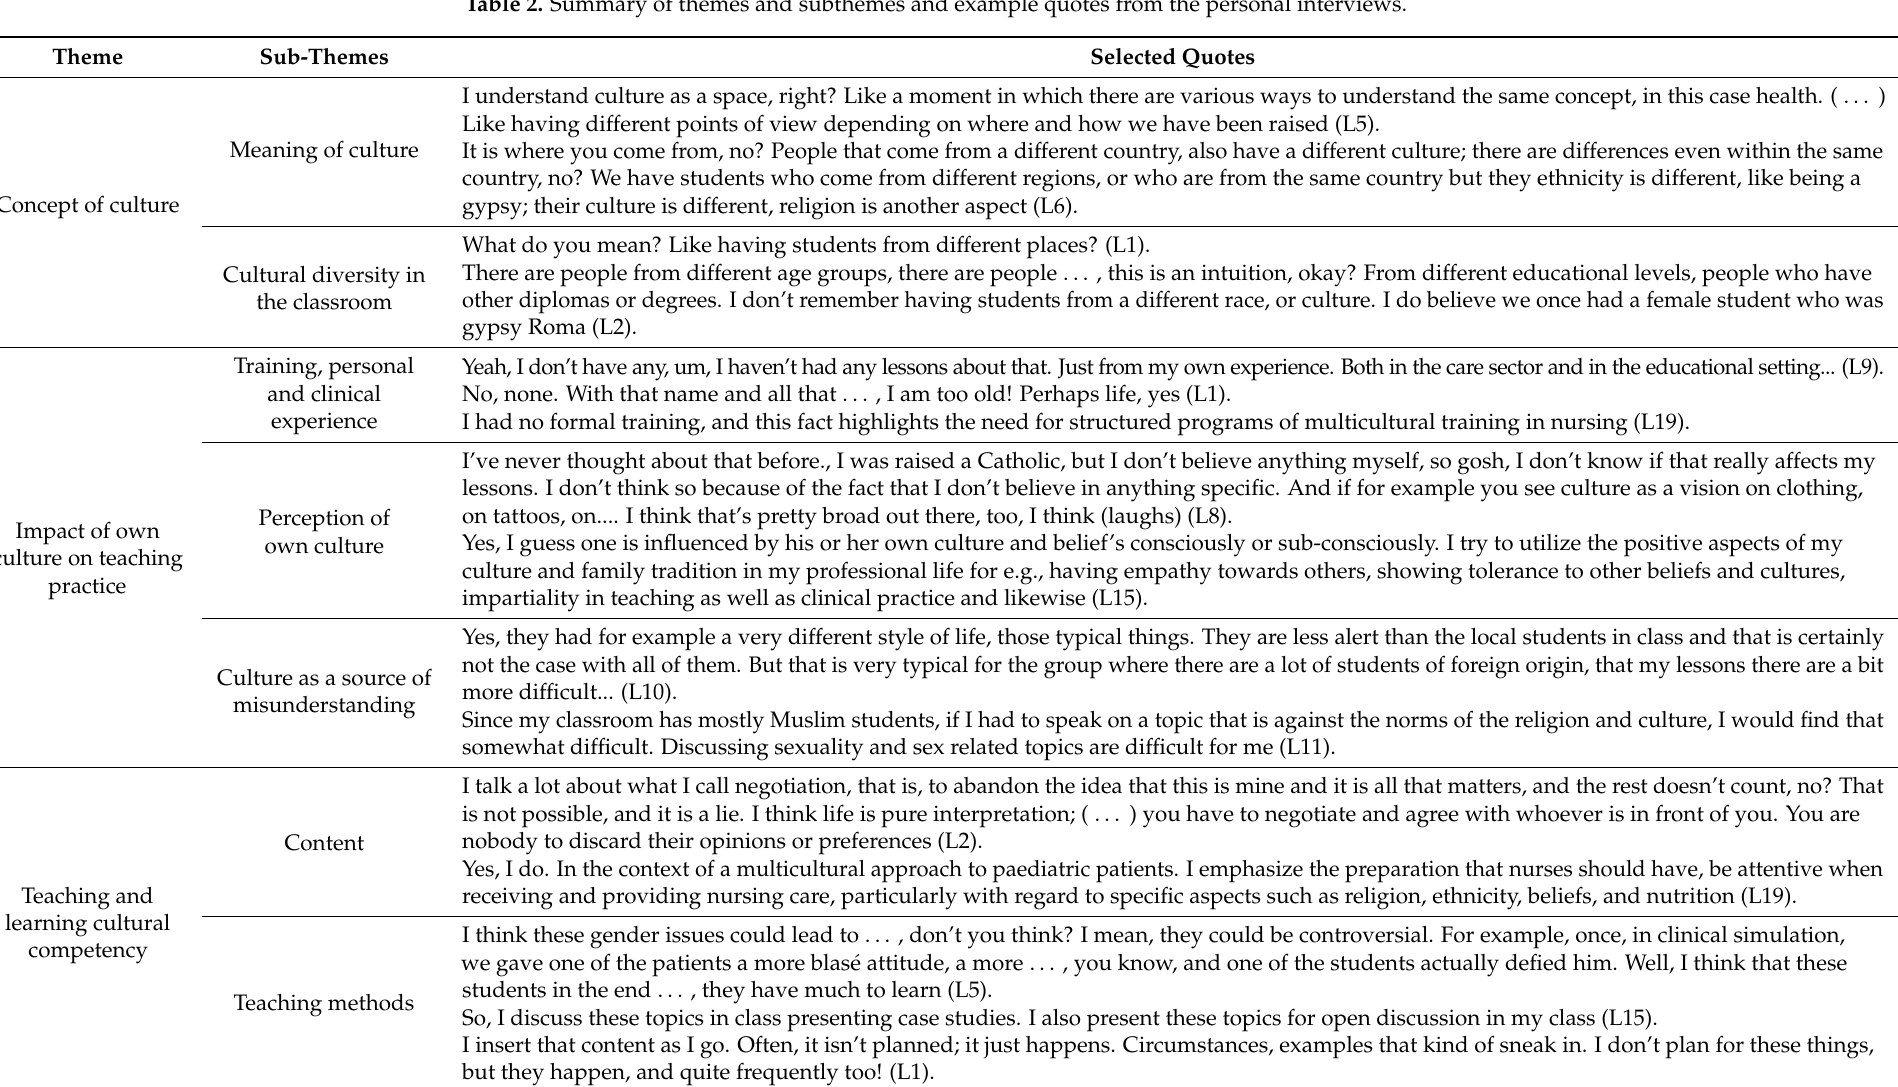
Table 2. Summary of themes and subthemes and example quotes from the personal